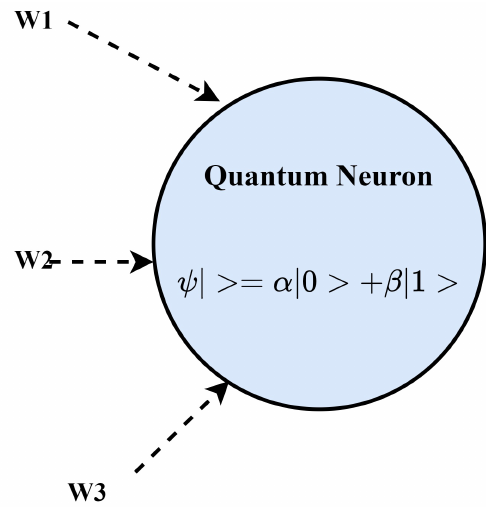
Figure 7. Quantum Neuron (W1, W2, W3 are the input